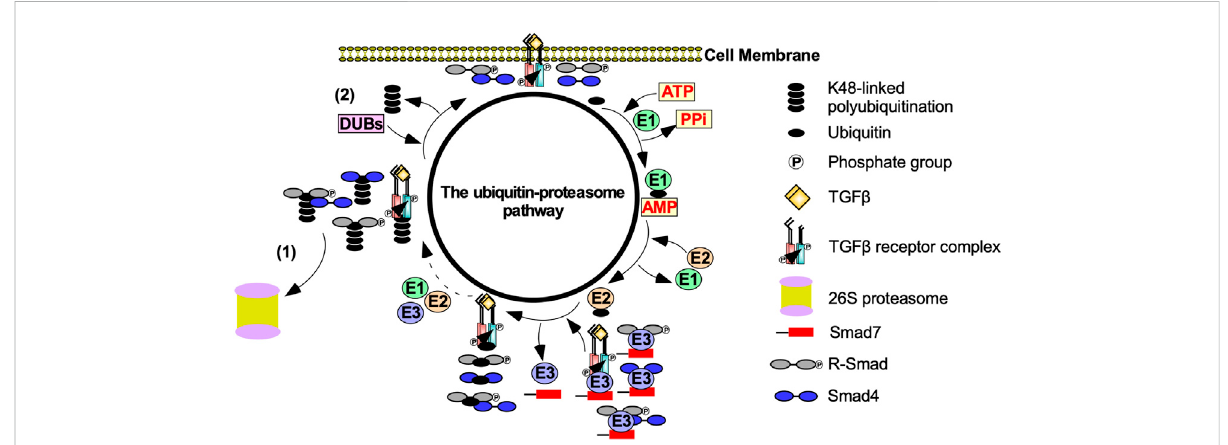
FIGURE 4 The effect of the ubiquitin-proteasome pathway on TGF β signalling. Transforming growth factor- β (TGF β ) signalling is tightly regulated by the ubiquitin-proteasome pathway. After TGF β binds to the TGF β -receptors, the ubiquitin-proteasome pathway is activated to prevent uncontrolled TGF β signalling.E1activatingenzymeshydrolasesATPtobindtoubiquitin.UbiquitinisthentransferredtoanE2conjugatingenzyme.Smad7bindsto E3 ubiquitin ligases, which conjugates ubiquitin to TGF β receptors, receptor Smads (R-Smads), Smad4, and R-Smad-Smad4 complexes. This process is repeated until TGF β receptors, R-Smads, Smad4 or R-Smad-Smad4 complexes are polyubiquitinated. Polyubiquitinated components of the TGF β pathway are then subject to (1) proteasome-dependent degradation or (2) the removal of the ubiquitin-linked chains mediated by deubiquitinating enzymes